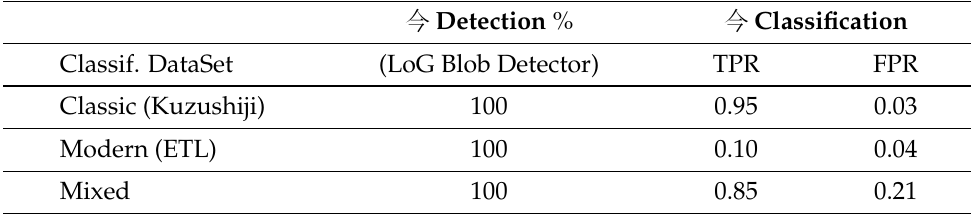
Table 1. “Ima” kanji detection and classification. 今 Detection % 今 Classification Classif. DataSet (LoG Blob